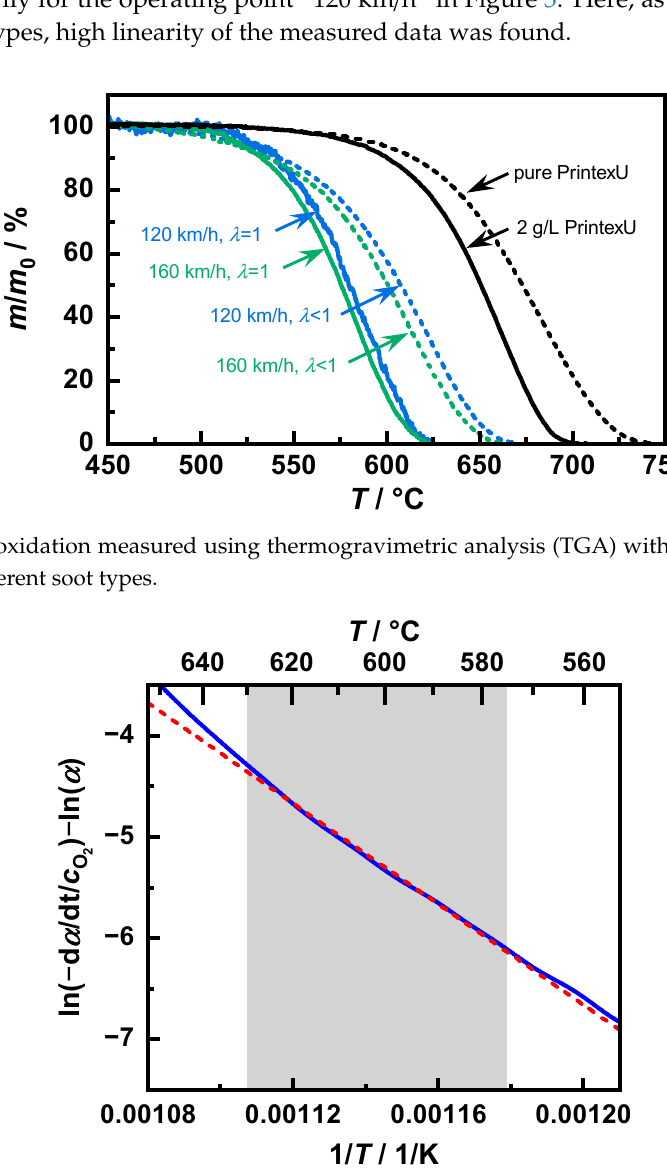
Table 1. Activation energy and pre-exponential factor of different soot types.